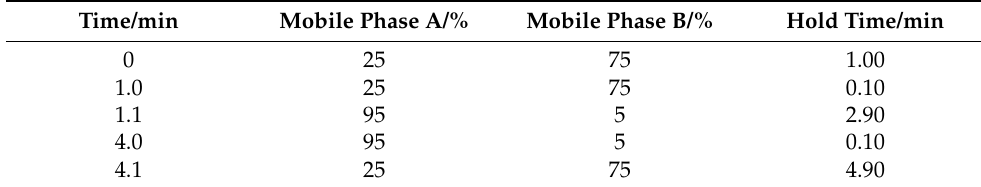
Table 1. Gradient elution program of the target